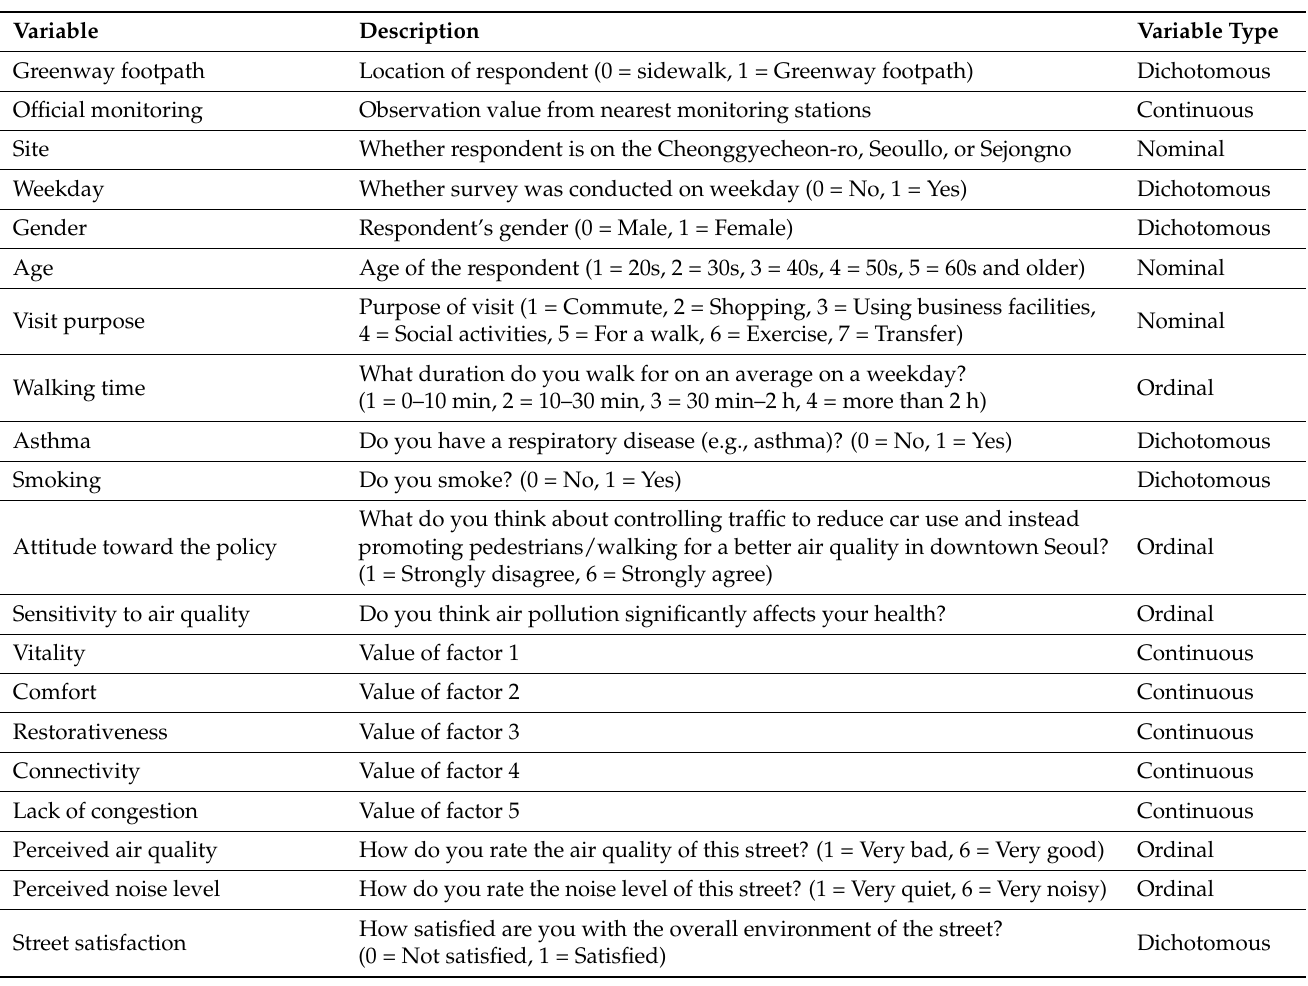
Table 3. Constructs and measurement